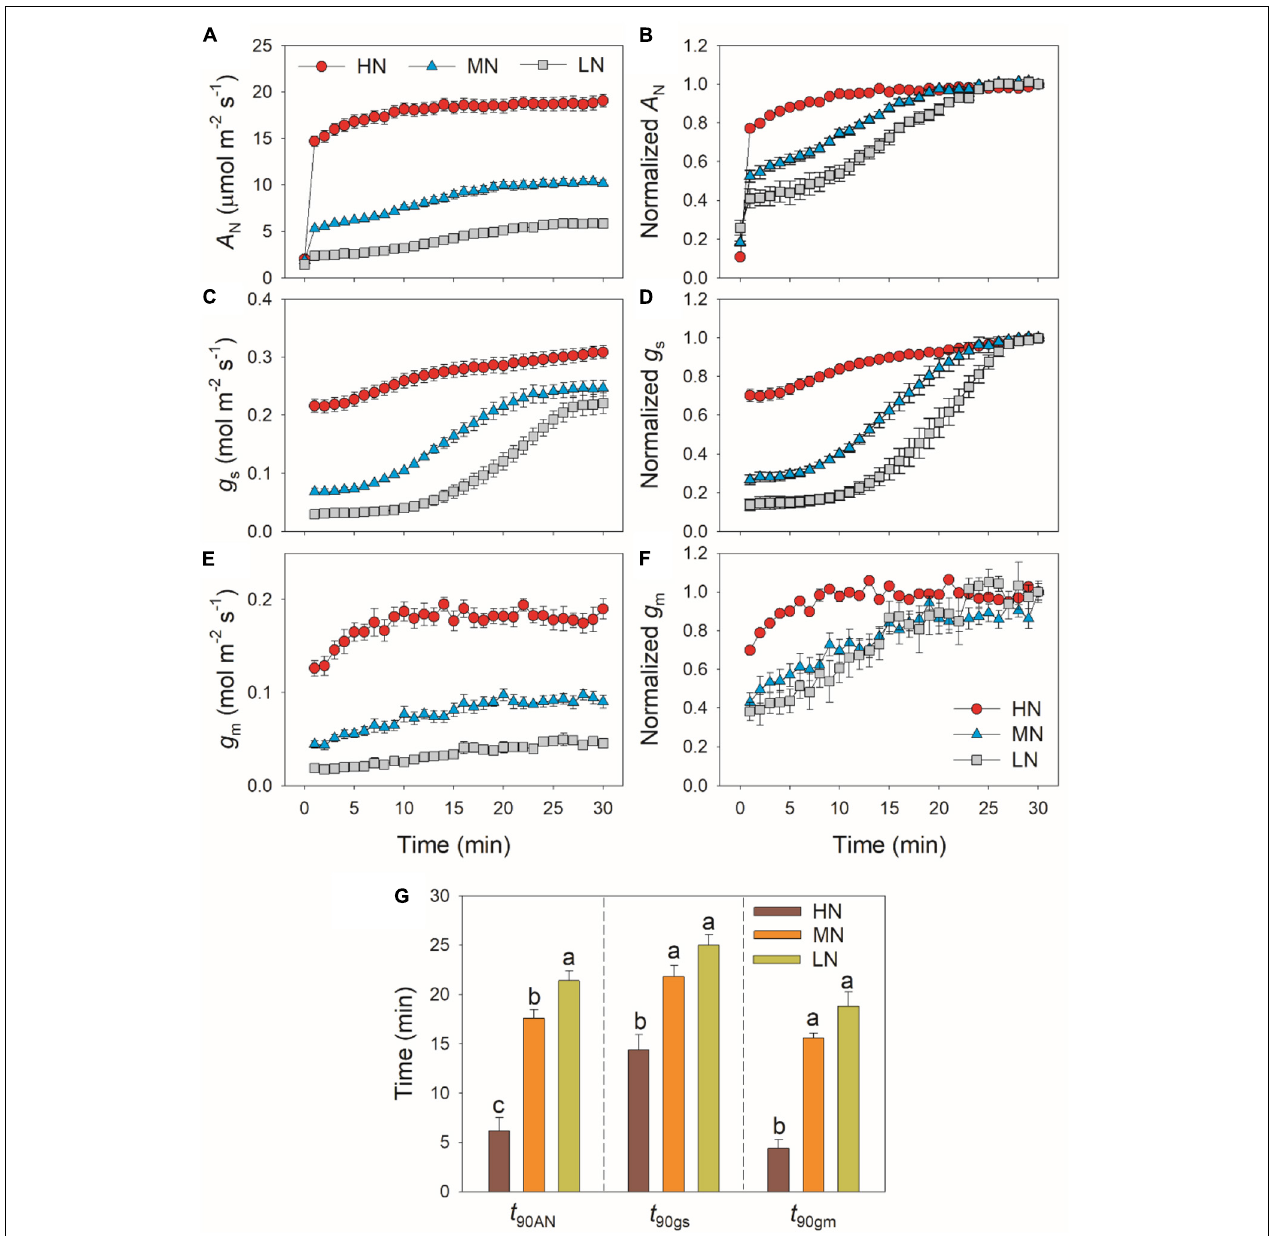
FIGURE 1 | Induction response of net CO 2 assimilation rate ( A N ) (A,B) , stomatal conductance ( g s ) (C,D) and mesophyll conductance ( g m ) (E,F) , and the time required to reach 90% of the maximum values of A N , g s and g m ( t 90 AN , t 90 gs , t 90 gm ) (G) after transition from 50 to 1,500 µ mol photons m − 2 s − 1 . A N , g s , and g m were measured every 1 min. Values are means ± SE ( n = 5). Different letters indicate significant differences among different treatments. The relative A N , g s , and g m curves were obtained from the standardization against the maximum values after 30 min photosynthetic induction at high light. HN, MN, and LN represent tomato plants grown under high, medium, and low N concentrations,